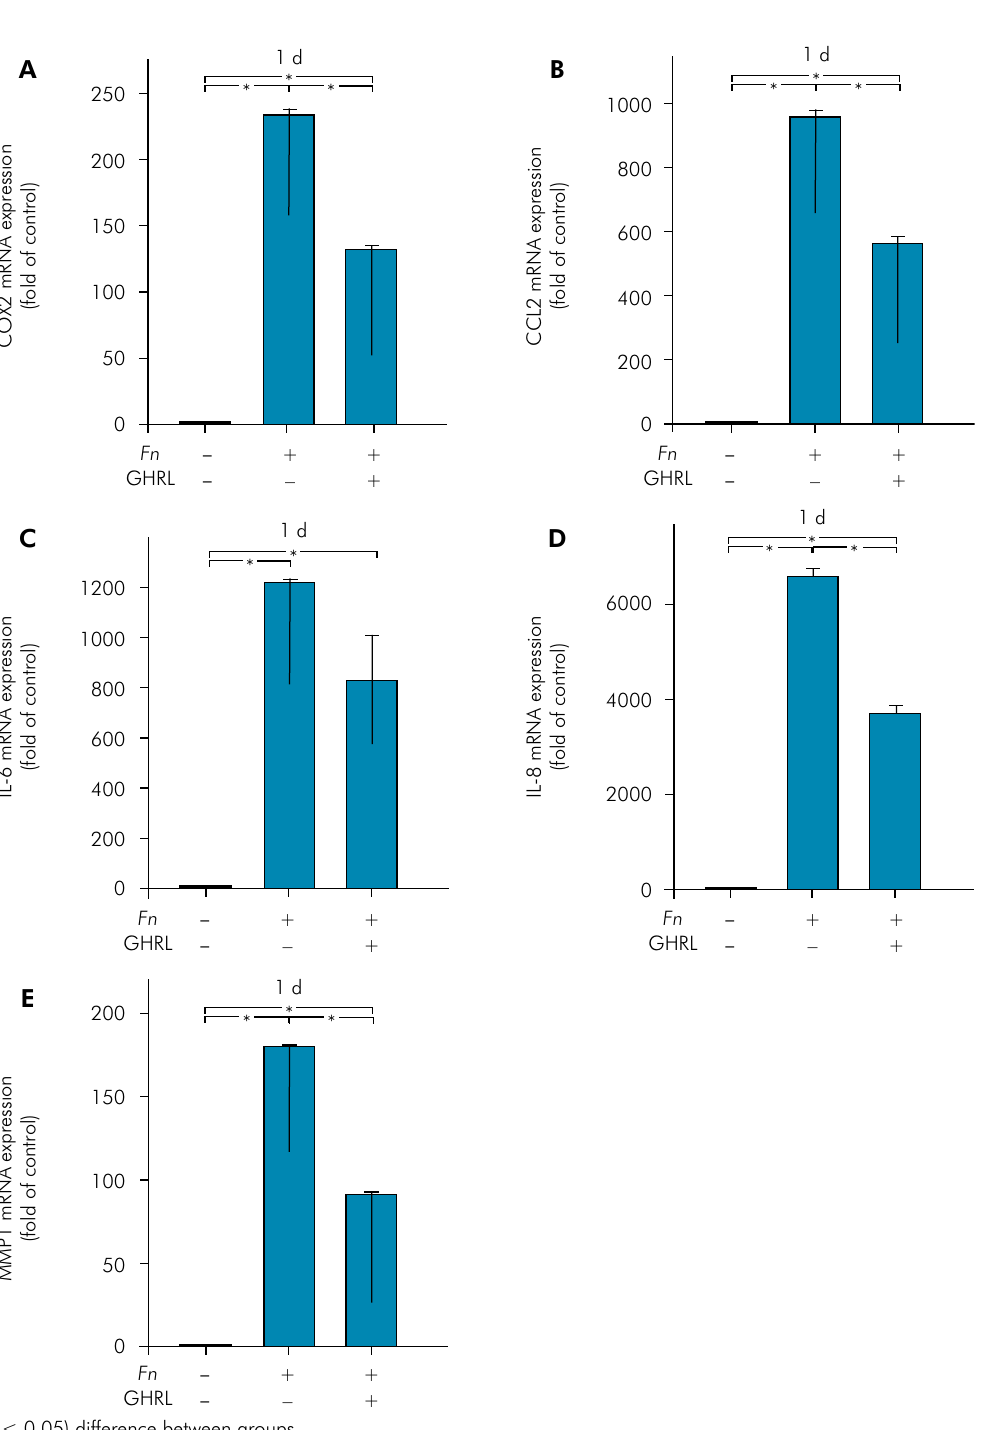
7 Braz. Oral Res.